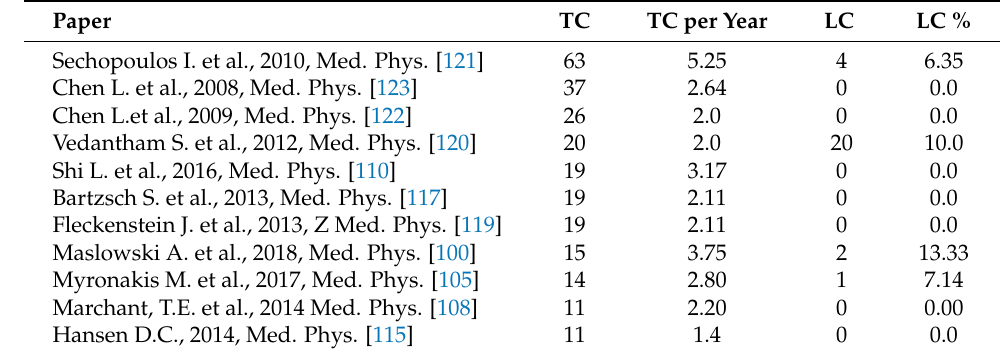
Table 4. Top 10 cited articles per author and journal. TC column shows the total citations, TC per year are the total citations per year, and LC are local citations, while LC % are the percentage of local citations.